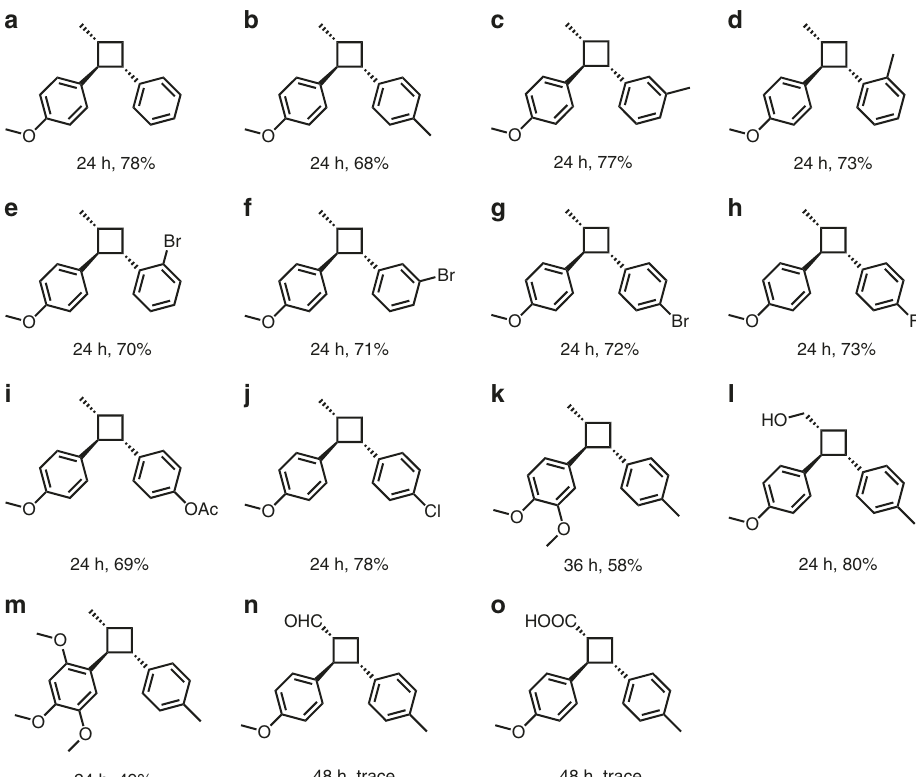
Fig. 5 Application of the fl ow reactor in heterogeneous photosynthesis. Scope of unsymmetrical [2 + 2] cycloaddition